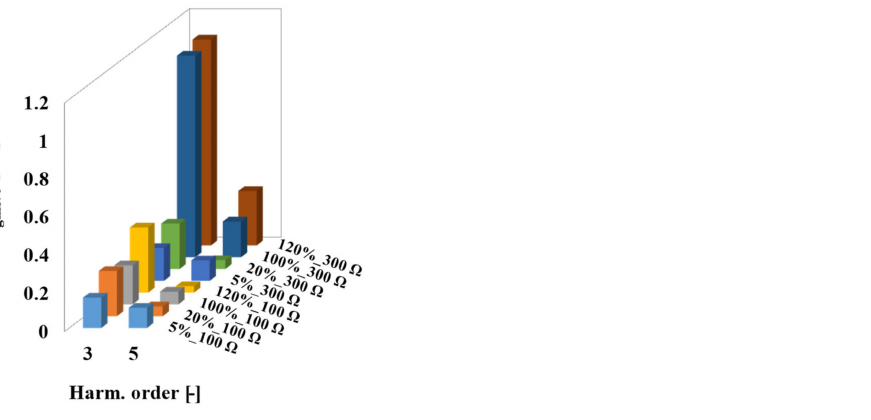
Figure 7. The percentage values of self-generation of the low-order higher harmonics of the tested ECT for two values of output loads, 100 Ω and 300 Ω , and four values of the primary currents, 5%, 20%, 100%, and